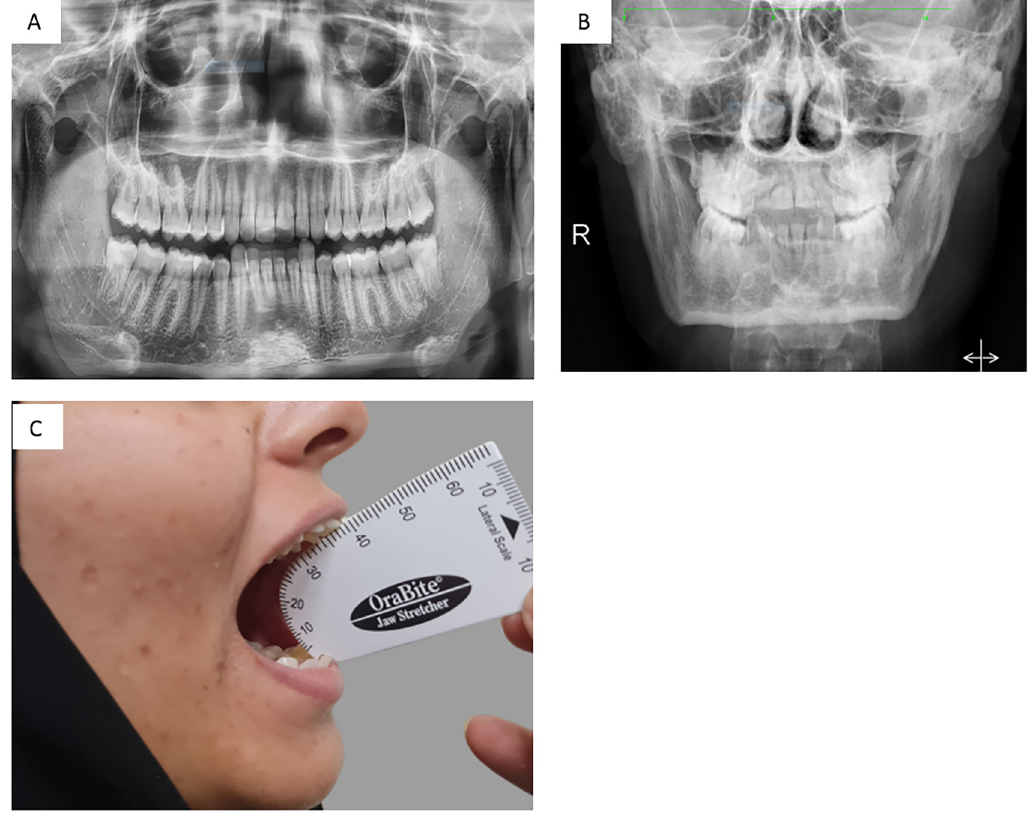
Fig. 4. One year postoperative results. A: Postoperative OPG; B: Postoperative PA; C: Mouth opening of 36mm.